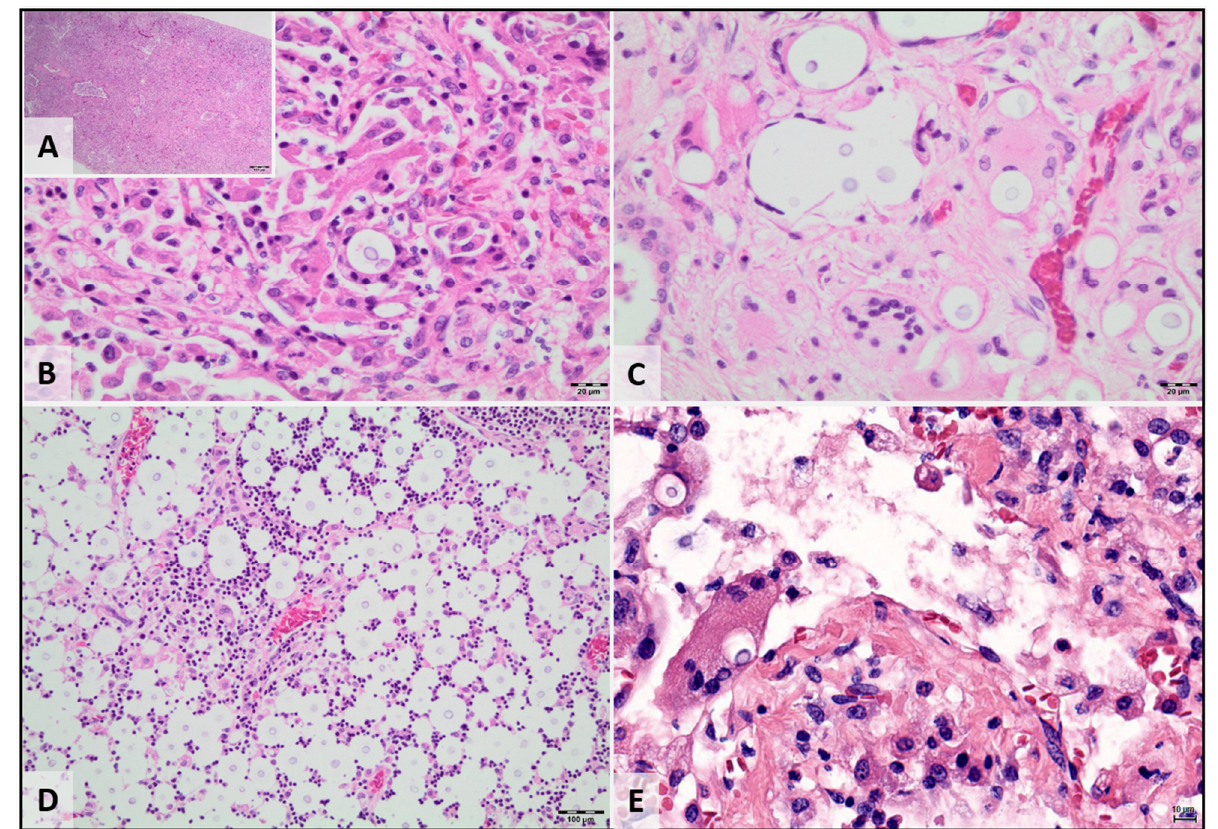
Figure 2. Cryptococcosis caused by C. gattii VGI in a 12 month old female koala ( A – D ) presenting with severe dyspnea and tachypnea and later developing seizures. ( A ) Lung at low magnification. There is marked consolidation of the pulmonary parenchyma. Some large airways containing exudate are evident. ( B ) The lungs exhibit a diffuse marked increase in cellularity due to an inflammatory infiltrate predominantly made up of macrophages. Note the budding yeast with the large negatively staining capsule. ( C ) In some parts of the specimen, the negatively stained capsule around the yeast is very large and there is an associated multinucleate giant cell macrophage response. ( D ) The thoracic lymph node exhibits a complete loss of normal architecture and is replaced almost entirely by large aggregates of encapsulated yeast cells, with some surrounding pyogranulomatous inflammatory infiltrate in places. ( E ) Lung at high magnification from a young male koala that presented with dyspnea, lymphadenomegaly and multifocal skin lesions associated with cryptococcosis caused by C. gattii VGI. There was significant widespread severe lung consolidation present at necropsy, in addition to multifocal lymph node involvement and multifocal skin lesions. Note the encapsulated yeast in the multinucleate giant cell macrophage.